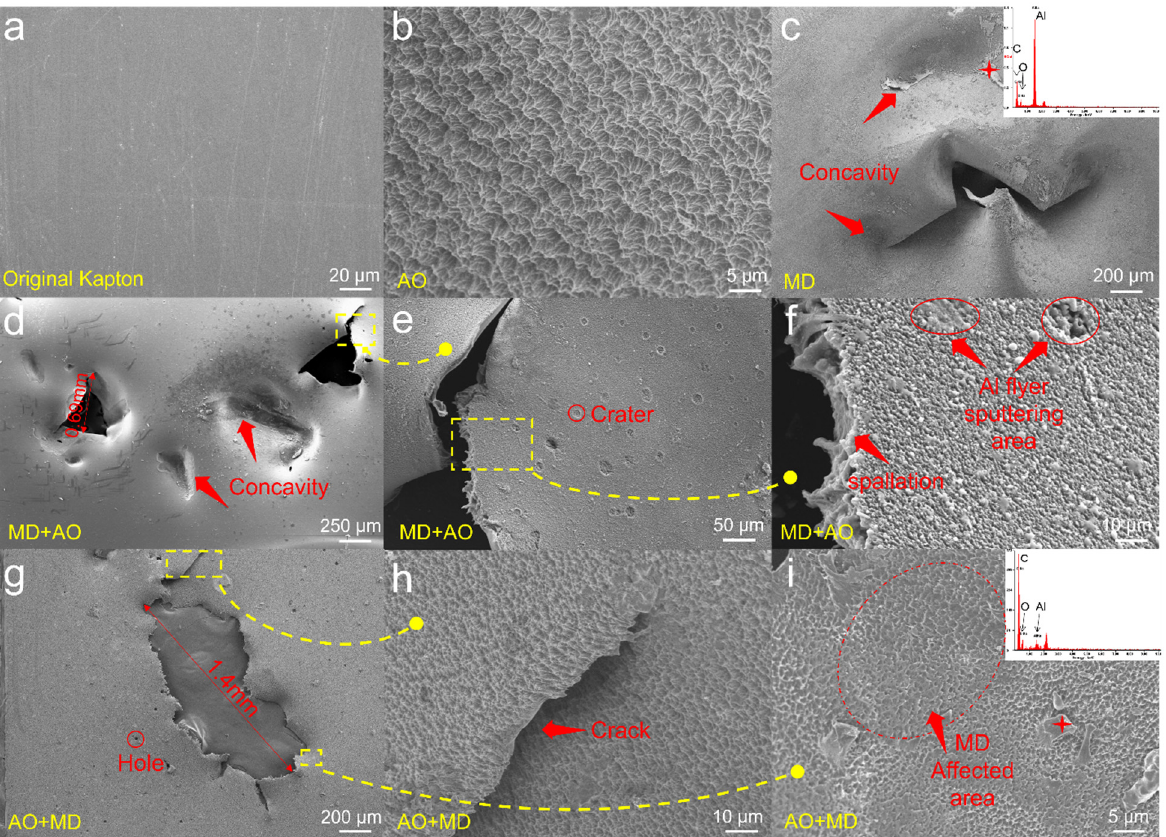
Figure 8. SEM surface morphology of Kapton film after different load spectrum tests: ( a , ×500) original Kapton film; ( b , ×2000) film after AO single factor load spectrum test; ( c , ×50) film after MD single factor load spectrum test; ( d , ×30); ( e , ×200); ( f , ×1000) film after MD + AO load spectrum test; ( g , ×50); ( h , ×1000); ( i , ×2000) film after AO + MD load spectrum test.